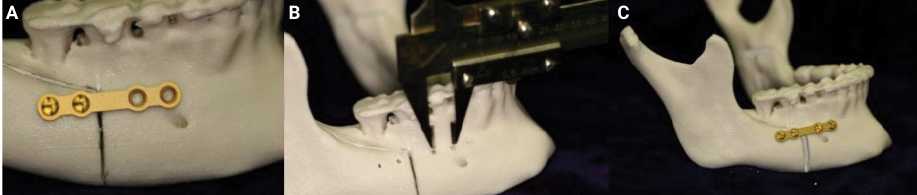
Figure 2. View of the sagittal split osteotomy (without the split at this moment) in a mandible prototype with a plate and 02 screws in the proximal fragment and the holes done with a number 1/2 spherical bur inside